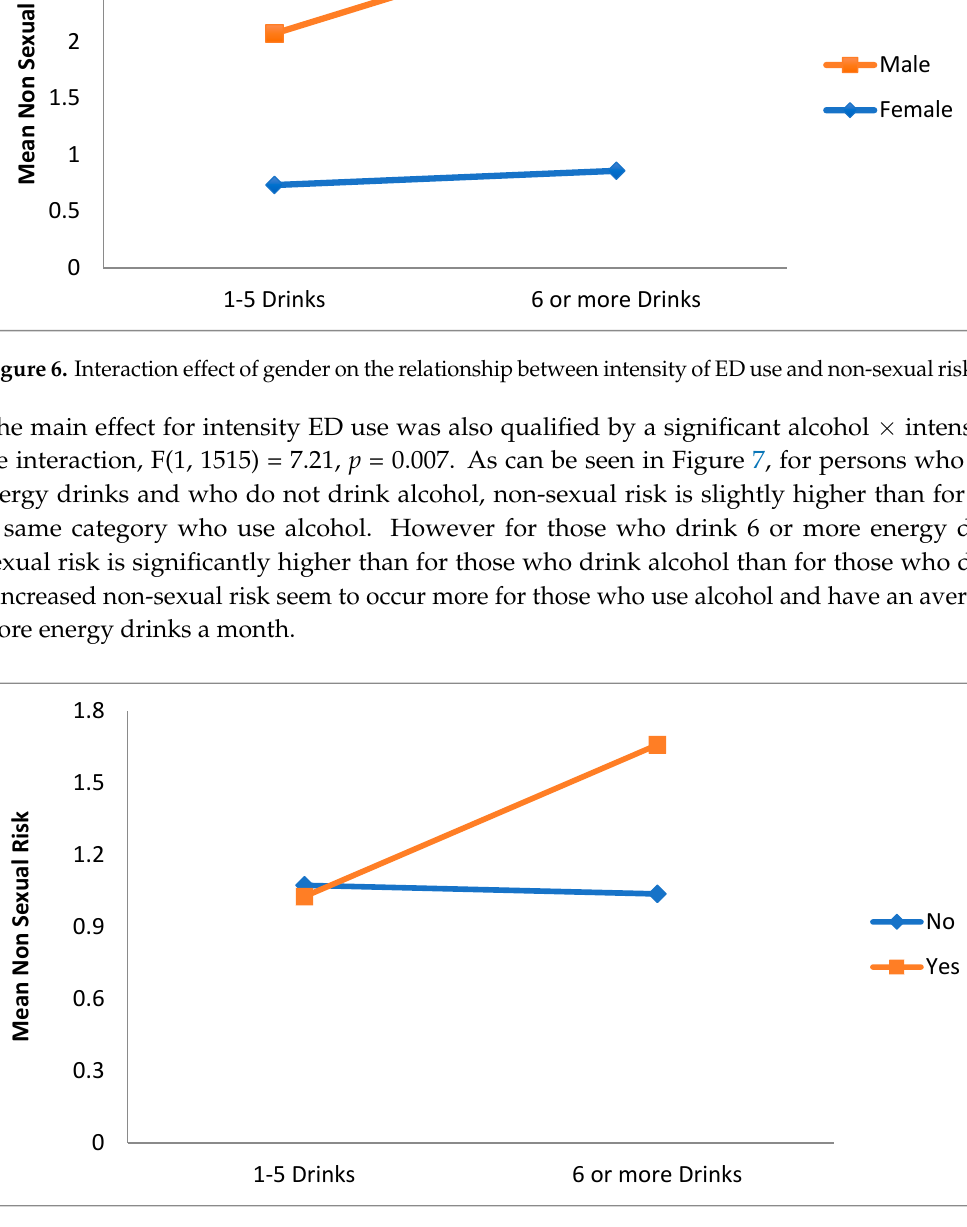
Figure 7. Interaction effect of alcohol use on the relationship between intensity of ED use and non-sexual risk.